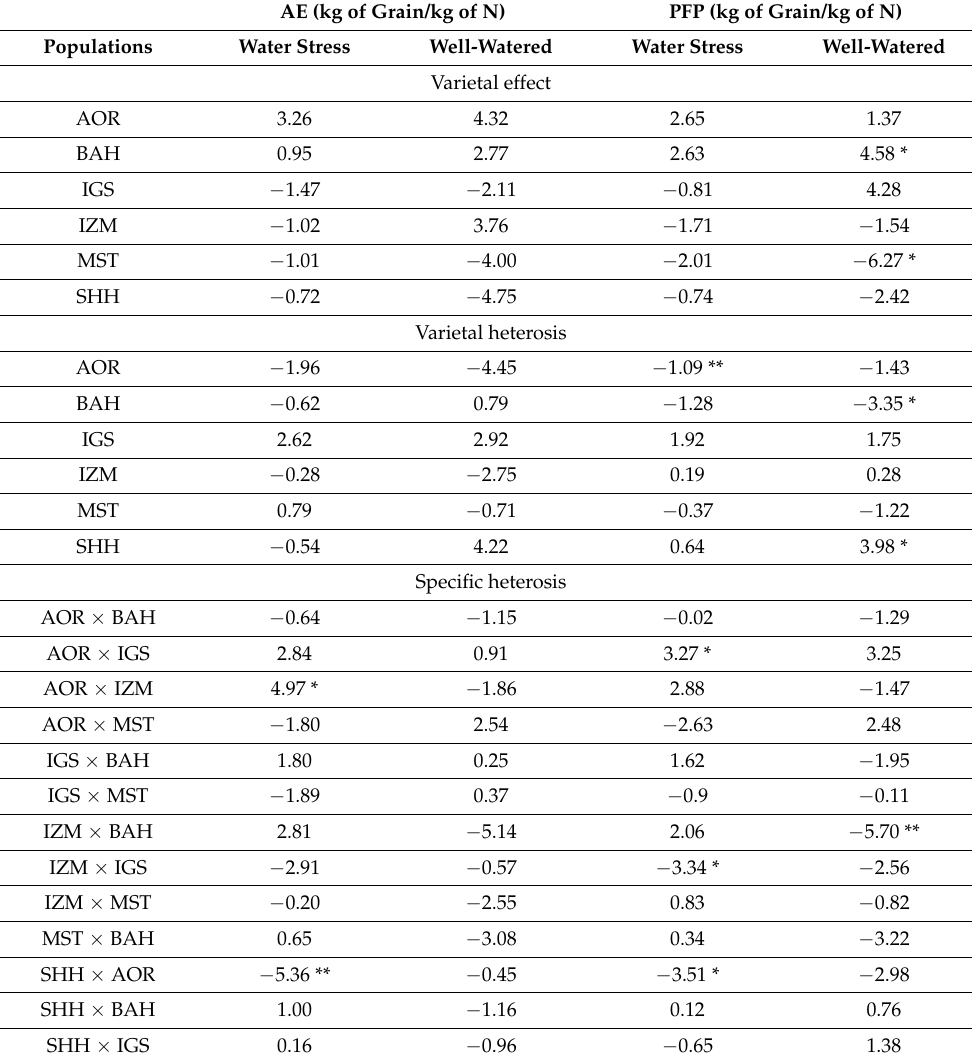
Table 9. Genetic parameters for agronomic efficiency (AE) and partial factor productivity (PFP) from the analyses of [61,77] (varietal effect, varietal heterosis, specific heterosis, and average heterosis) for two traits in the diallel made among six Algerian maize populations evaluated in two years in Algiers under both managed drought and nitrogen